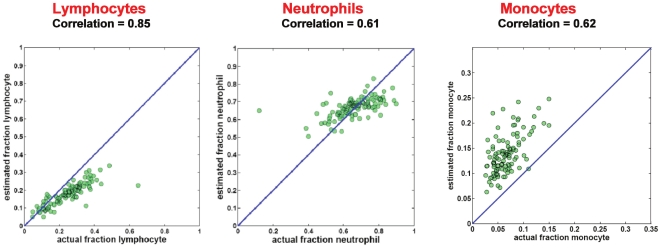
Comparison of CBC data and statistical deconvolution in whole blood samples.Determination in whole blood samples of relative abundance of total lymphocytes, neutrophils, or monocytes by CBC compared to determination of relative abundance by deconvolution. Each green dot here corresponds to one sample in the dataset. Diagonal lines are y = x, shown for reference, highlighting the agreement between the two methods.